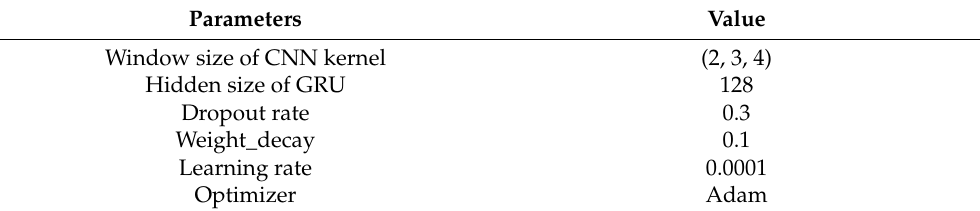
Table 2. Experimental parameters setting.